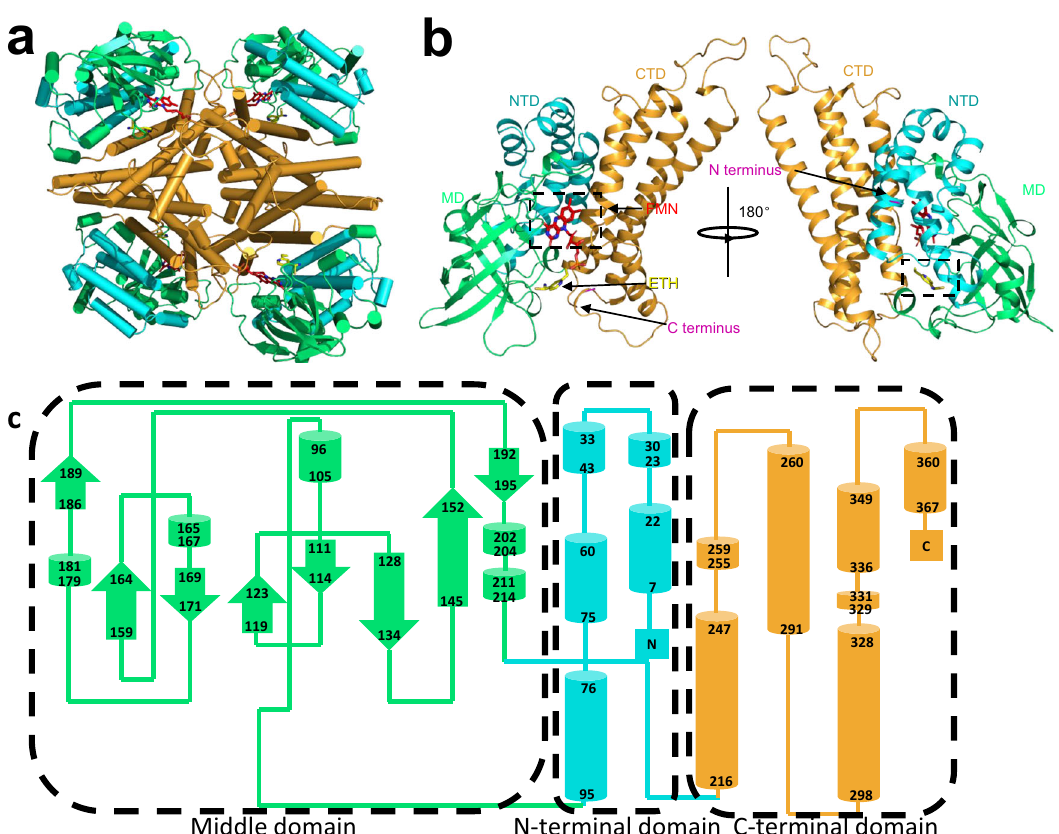
Fig. 5 Structure of the Rv3094c-FMN-ETH complex. a Ribbon diagram of the Rv3094c-FMN-ETH tetramer. Cyan: N-terminal domain (residues 7 – 95); green: middle domain (96 – 214); orange: C-terminal domain (216 – 376). b Overall structure of the Rv3094c-FMN-ETH monomer, color-coded as de fi ned